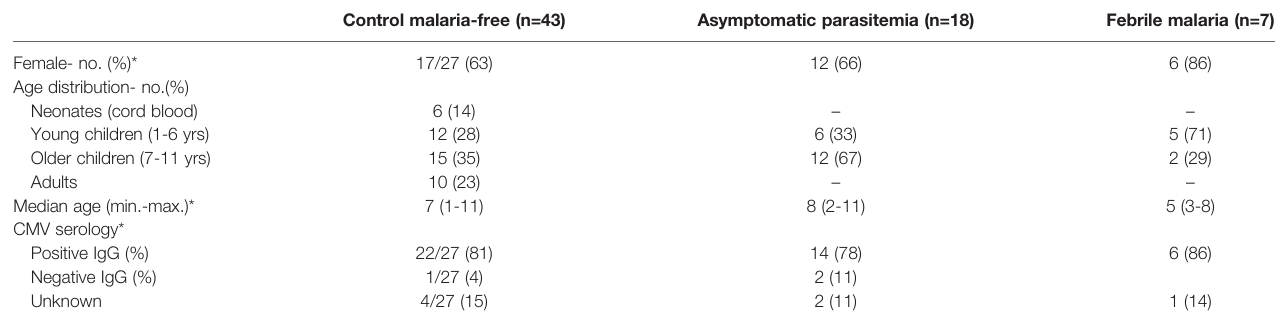
TABLE 1 | Demographic characteristics of the patients. Control malaria-free (n=43) Asymptomatic parasitemia (n=18) Febrile malaria